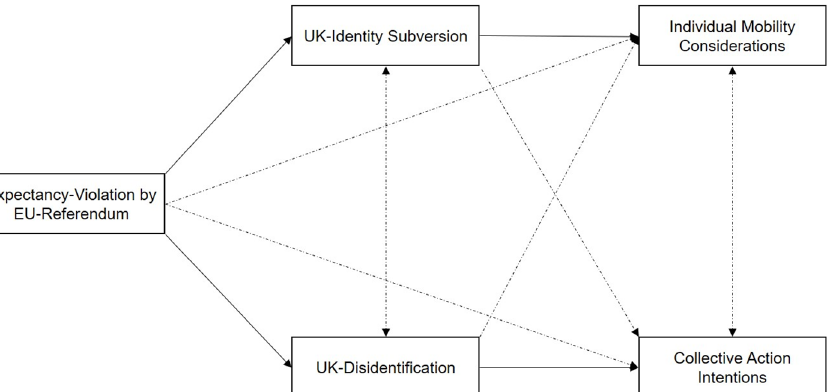
Note. Solid lines represent hypothesised relations, dashed lines represent additional relations that were modelled when testing the